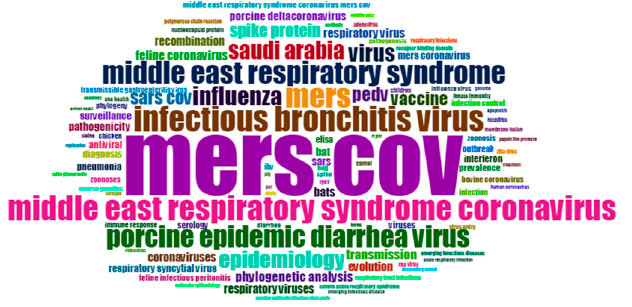
Figure 9. Keywords cloud map of 2016–2019. Table 9. Items and frequency of hot keywords during 2012 – 2018.